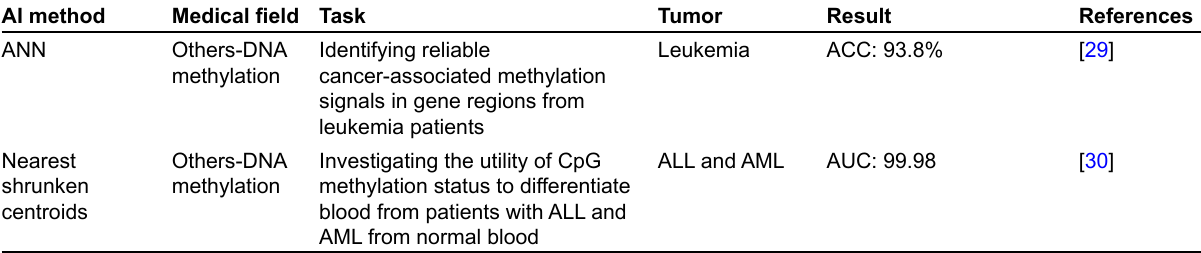
Table 1. Current AI applications in the diagnosis of childhood non-solid tumor ( continued ) AI